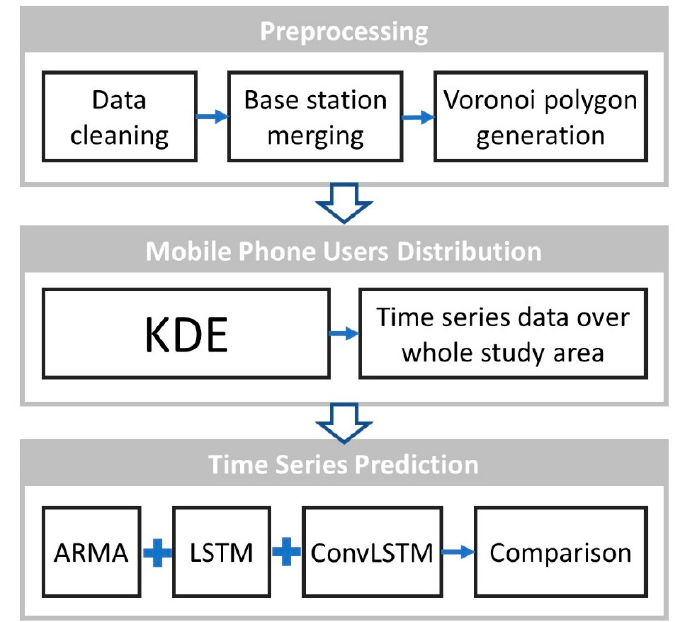
Figure 2. Method overview to perform a temporal and spatial prediction of mobile phone users.